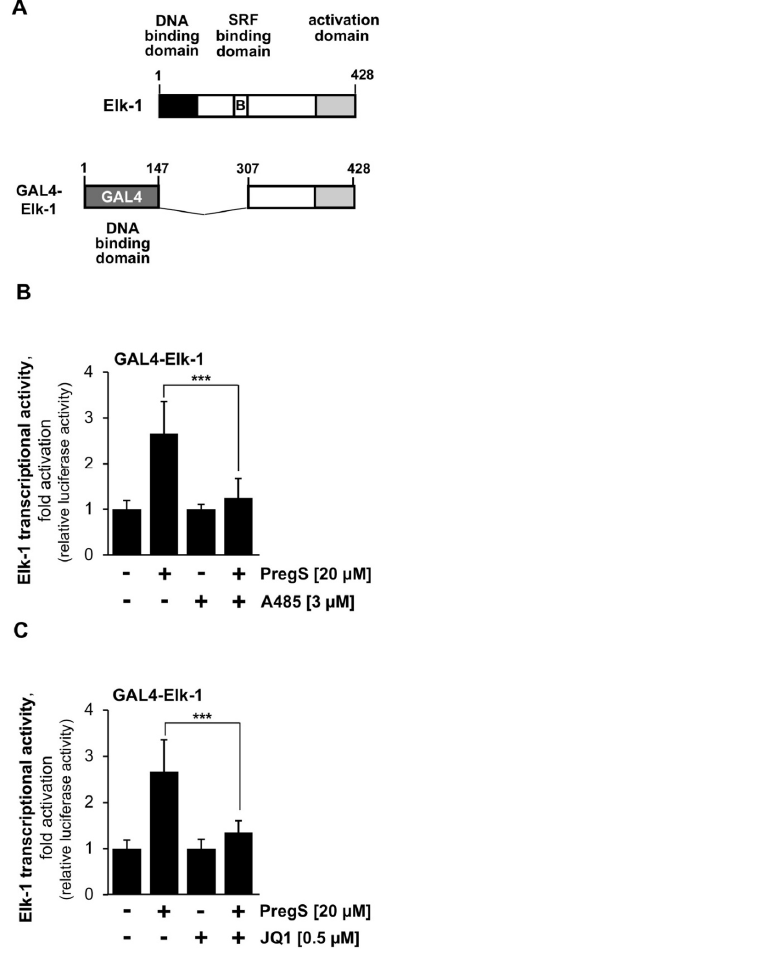
Figure 5. CBP/p300 and BET inhibitors reduce the transcriptional activation potential of Elk-1 in stimulated T-REx-TRPM3 cells. ( A ) Domain structure of GAL4-Elk-1 ( B , C ) T-REx-TRPM3 cells were infected with a lentivirus containing the UAS 5 Sp1 2 .luc reporter gene. Cells were infected with a sec- ond lentivirus that encoded for the GAL4-Elk-1 fusion protein. T-REx-TRPM3 cells were maintained in serum-reduced and tetracyclin-supplemented medium for 24 h. Stimulation was performed with preg- nenolone sulfate (PregS, 20 μ M) for 24 h. Addition of either A485 (3 μ M) ( B ) or JQ1 (0.5 μ M) ( C ) is indi- cated. Cells were harvested and analyzed as described in the legend to Figure 2 ( n = 3; *** p < 0.001). 2.5. Measurement of cAMP Response Element-Mediated-Mediated Transcription Using a CRE- Containing Reporter Gene and a CREB Mutant